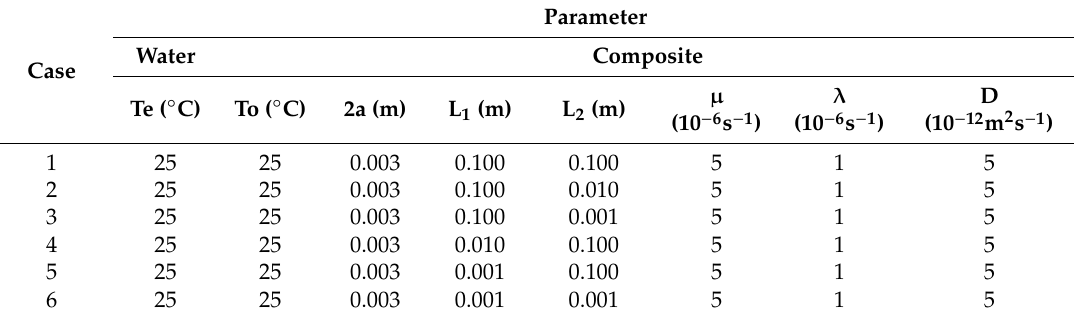
Table 1. Process parameters (Temperature, thickness, probabilities and di ff usivity) values used in the